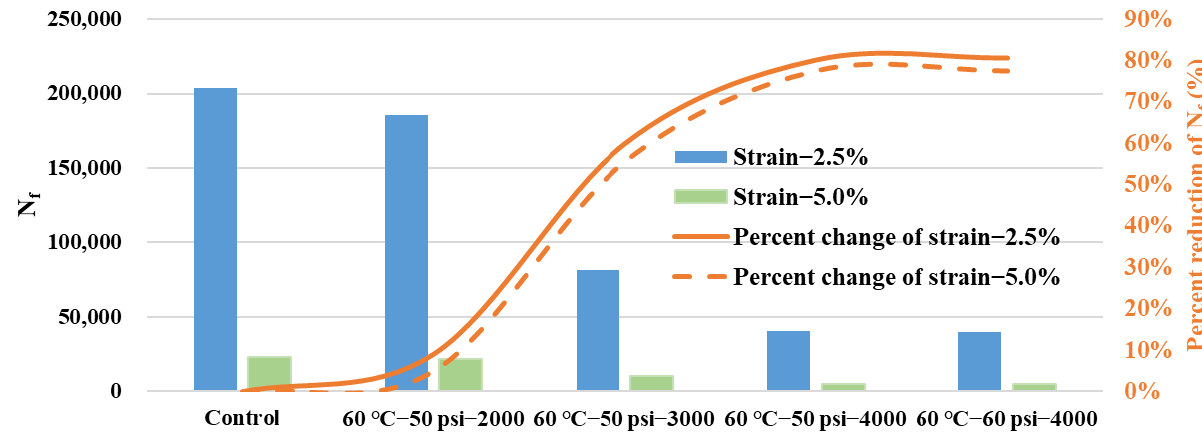
Figure 10. Fatigue life of asphalt binder in LAS tests.